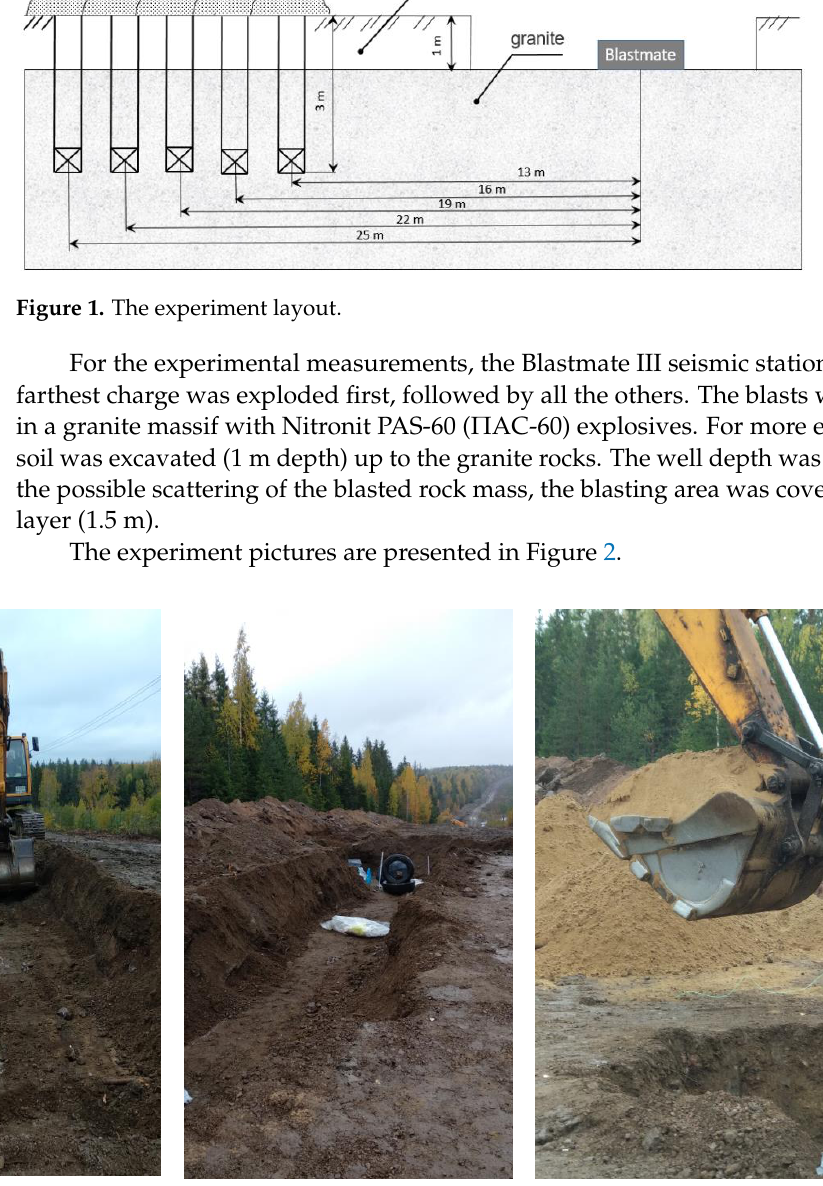
Figure 2. The experiment layout.